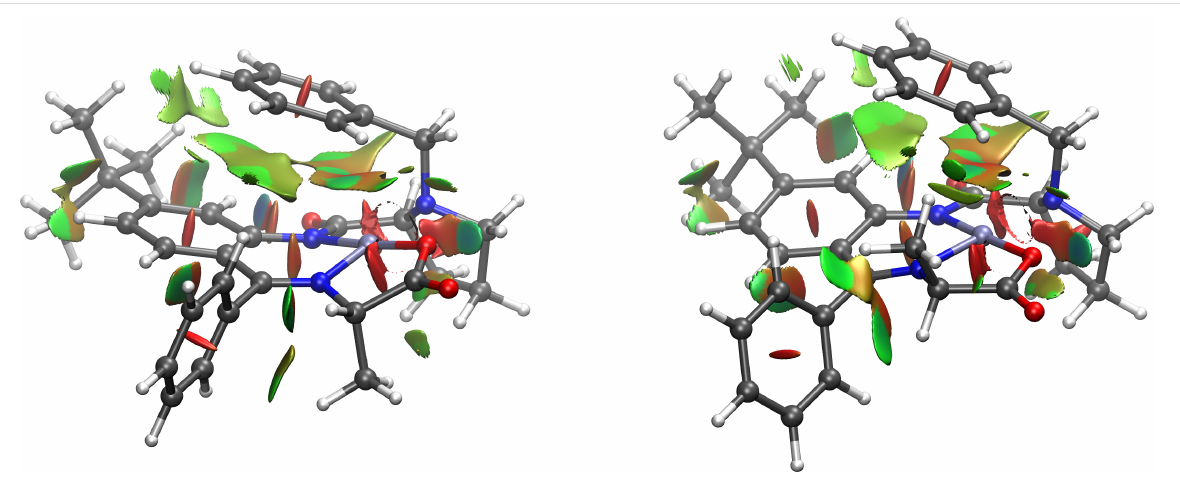
Figure 2: Low-gradient isosurfaces with low densities (blue color of the isosurface corresponds to the hydrogen bonding; the dispersion interactions (van der Waals interactions, the π -stacking) are marked in green color; red color indicates steric clashes) obtained for the ʟ - (left image) and ᴅ -alanine (right image) Ni–Schiff base derivatives with ligand L7